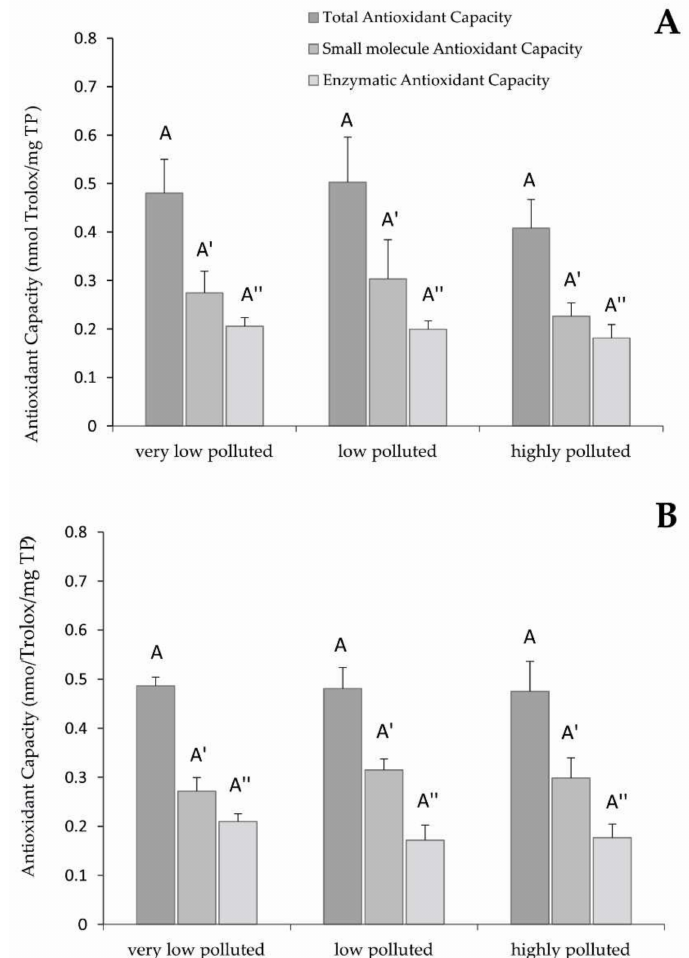
Figure 3. Total antioxidant capacity (sum of small molecules antioxidant capacity and enzymatic antioxidant capacity) of ( A ) S. cephalus and ( B ) P. bonelli liver. Values (nanomoles of Trolox per milligrams of total proteins) are indicated as mean ± SD. Different letters correspond to significant statistical differences ( p < 0.005) among different sites (ANOVA test). P. bonelli : three specimens per site. S. cephalus : four specimens per site were singularly